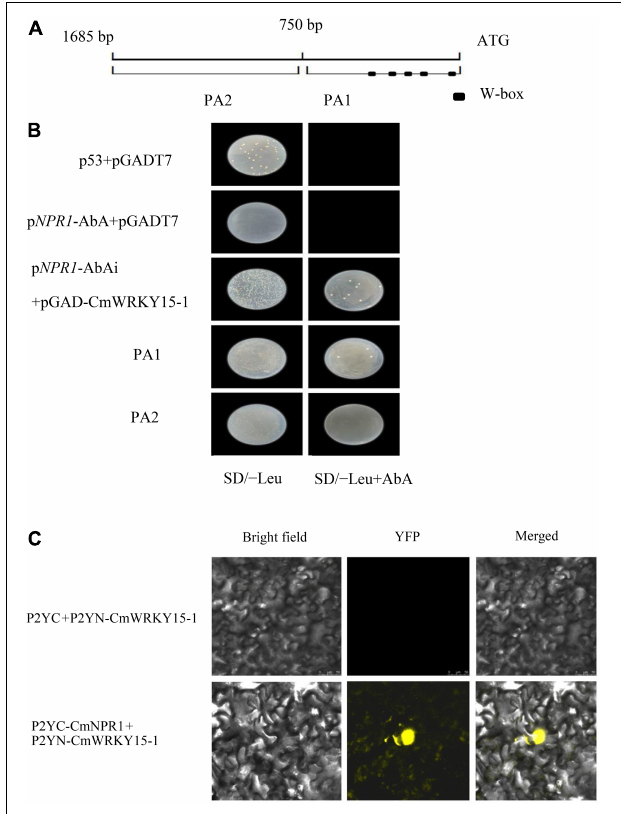
FIGURE 7 | Regulatory relationship between CmWRKY15-1 and CmNPR1 . (A) Schematic diagram of the 1,600-bp CmNPR1 promoter. PA1, 0 to –750 bp; PA2, –750 to –1,685 bp; squares indicate W-box elements. (B) Yeast one-hybrid (Y1H) analysis of CmWRKY15-1 binding to the CmNPR1 promoter. (C) Fluorescence confocal detection of Nicotiana benthamiana mesophyll cells. Bright field, visible images; YFP, yellow fluorescent protein images; Merged, merged fluorescence, and visible